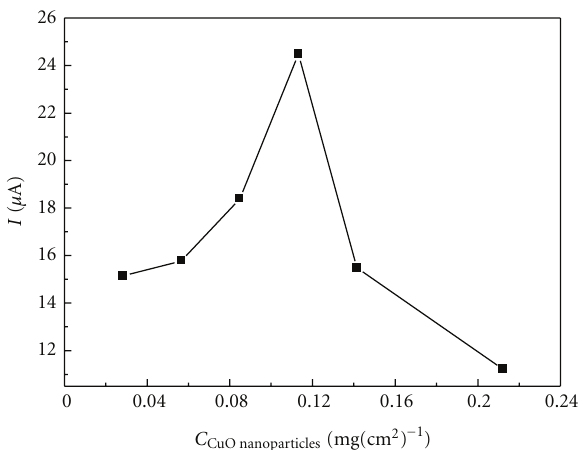
Figure 6: Amperometric current-time curves for H 2 O 2 oxida- tion on the nano-CuO/GCE, at applied potential 0.19 V (versus Ag/AgCl) in 0.01 M NaOH + 0.09M KCl solution. Concentrations were used in the range between 0.02 μ M and 250 μ M H 2 O 2 . (a) the current-time curves for adding 0.02, 0.06, and 0.2 μ M of H 2 O 2 . (b) the current-time curves for adding 2, 6, and 20 μ M of H 2 O 2 . (c) showed I pa versus C H 2 O 2